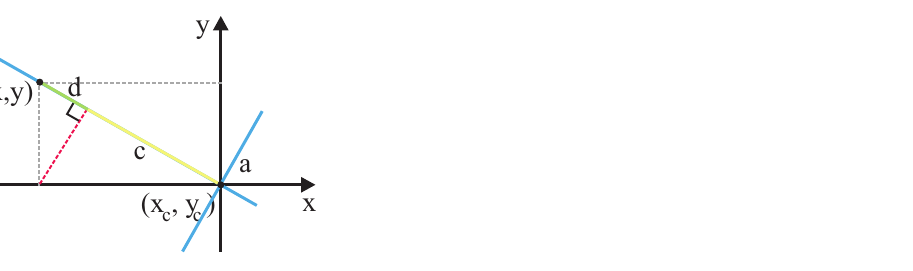
Figure 9. Calculus of distance in sagittal axis for a given ( x , y ) point in the reference frame.